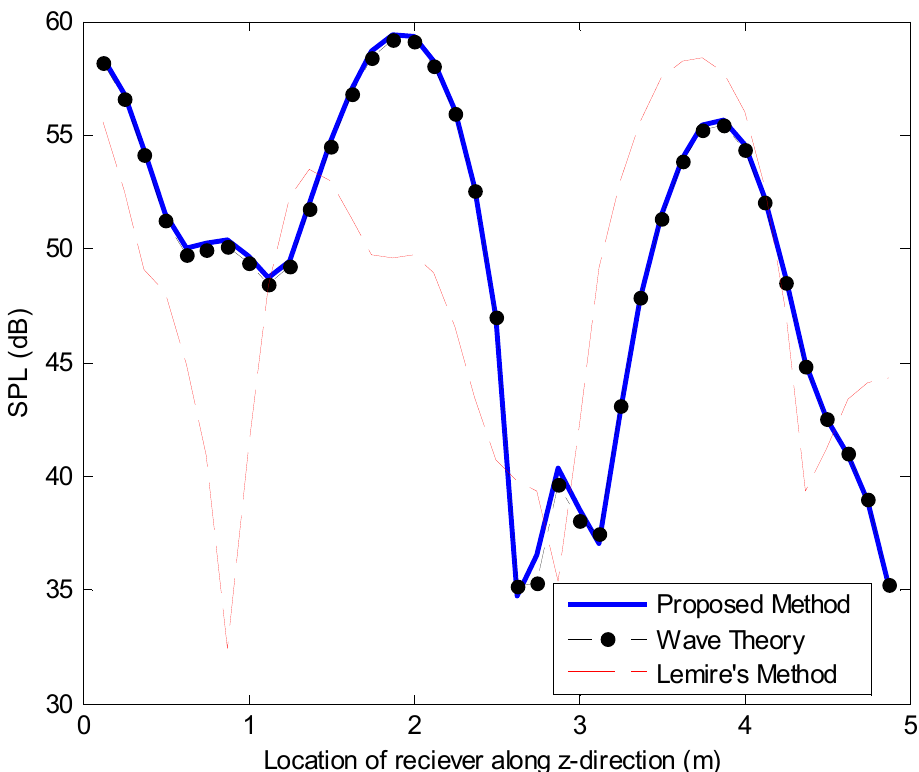
Figure 5. Comparison of predictions on sound pressure level (SPL) at a frequency of 1000 Hz vs. the receiver location along the x -direction. The source is located at (6 m, 0 m, 1 m) and the receiver is located at ( x r , 50 m, 1 m) with x r moving from 1 m to 19 m. The solid line represents the results with the proposed method, the solid circles are those with the wave theory that is considered as a benchmark, and the dash line is the result with the method of Lemire and Nicolas (Lemire’s method).